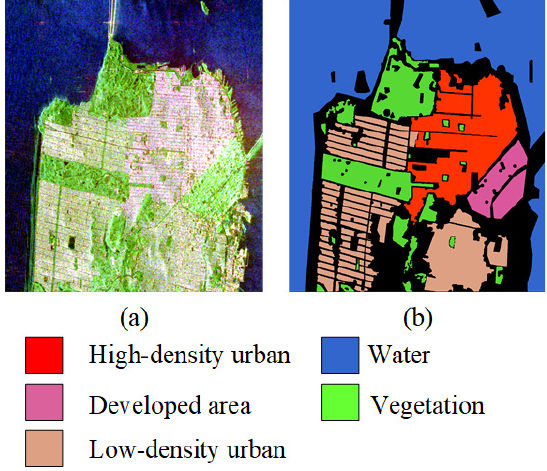
Figure 7. San Francisco image. ( a ) pseudo-RGB image. ( b ) ground